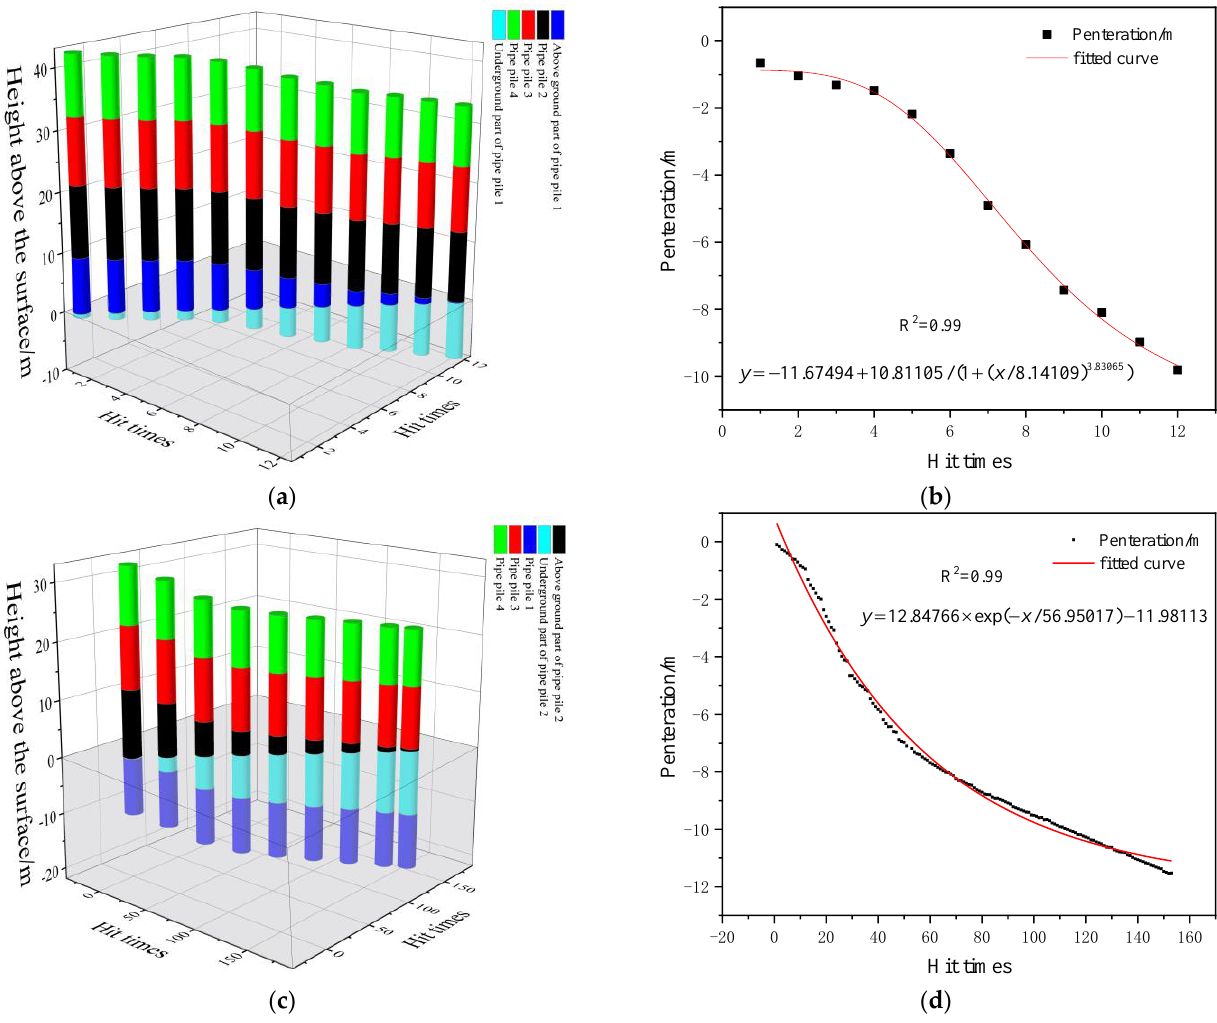
Figure 9. Schematic diagram of penetration change in first and second pipe piles at pile position 6, displaying the ( a ) spatial diagram of penetration evolution law of pipe pile 1, ( b ) fitting analysis of penetration evolution law of pipe pile 1, ( c ) spatial diagram of penetration evolution law of pipe pile 2, and ( d ) fitting analysis of penetration evolution law of pipe pile 2. Table 4. Monitoring data of pipe pile penetration at No. 6 pile position.